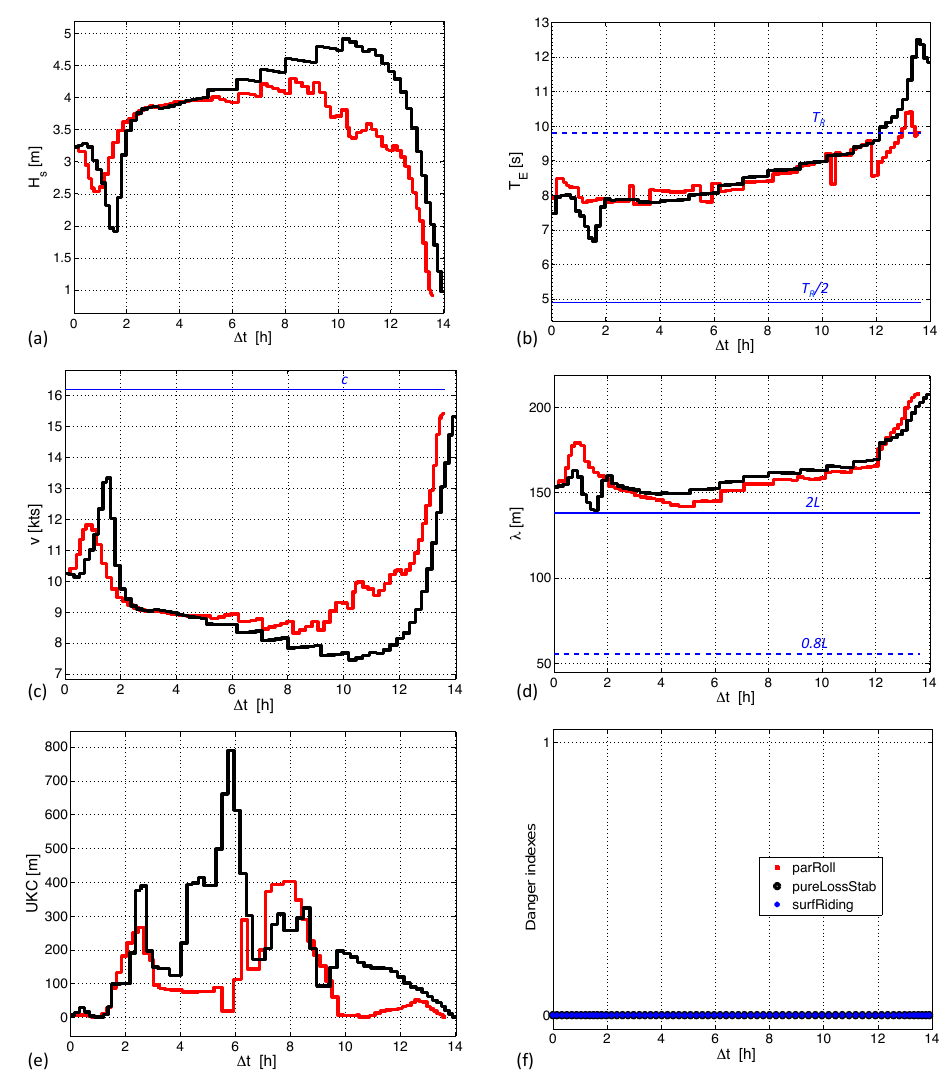
Figure 11. Case study #1. Information along geodetic (black) and optimal (red) route of Fig. 10: (a) significant wave height H s ; (b) encounter wave period T E ; (c) sustained speed v ; (d) wavelength λ ; (e) under keel clearance UKC; (f) danger indices along geodetic route, 0: safe; 1: dangerous. The quantities T R , c , L refer to vessel V1 of Table 5.